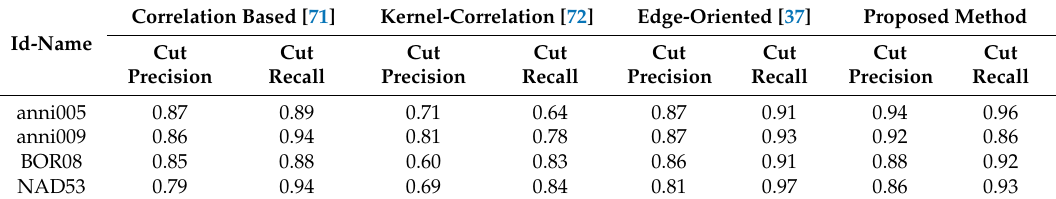
Table 14. The comparison results of the cut shot detection.